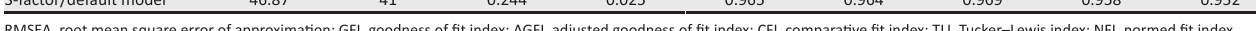
TABLE 3: Confirmatory factor analysis results. Scale